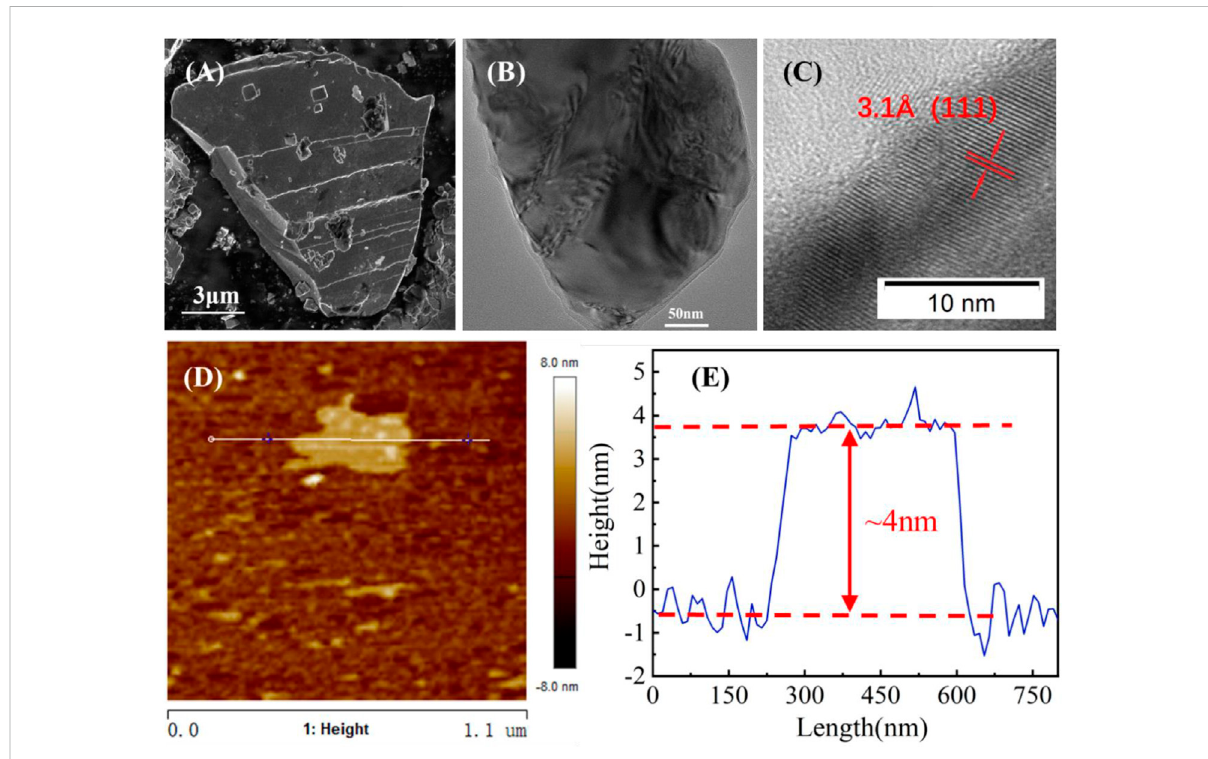
FIGURE 1 Characterizations of few-layer Ge-Ns. (A) SEM image of the germanene crystal powder sample; (B,C) HRTEM image with higher resolution; (D) AFM images; and (E) corresponding thickness pro fi le of